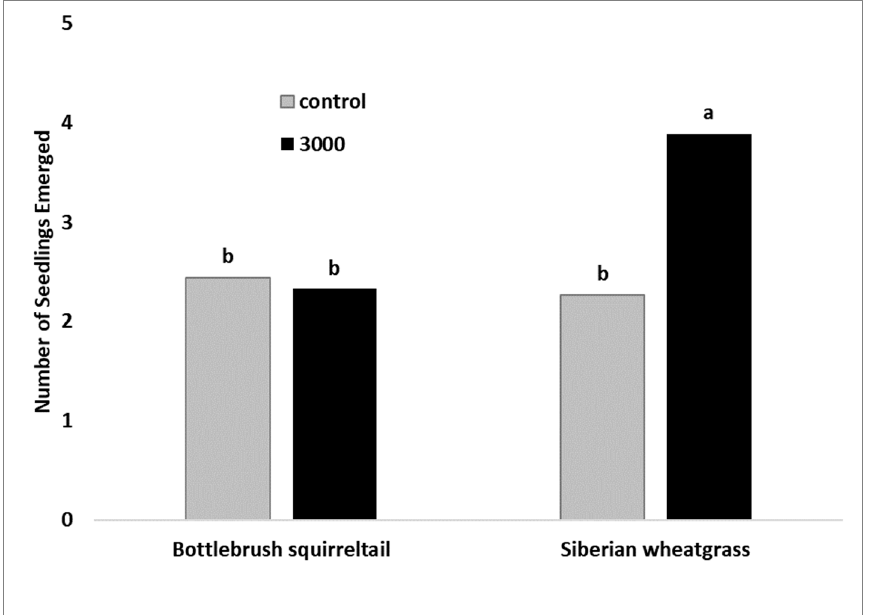
Figure 10. Number of seedlings emerged as a function of superabsorbent polymer (SAP) application averaged across applied fertilizer depths of 0 and 8 cm and 77 d of a glasshouse study with bottlebrush squirreltail and Siberian wheatgrass. The SAP rate of 3000 kg ha − 1 was placed in a band at a depth of 8 cm directly below the seed. Following SAP treatment, the soil was saturated once and then dried down naturally over the time of the study. Bars with the same letters are not statistically different from each other. p = 0.05.